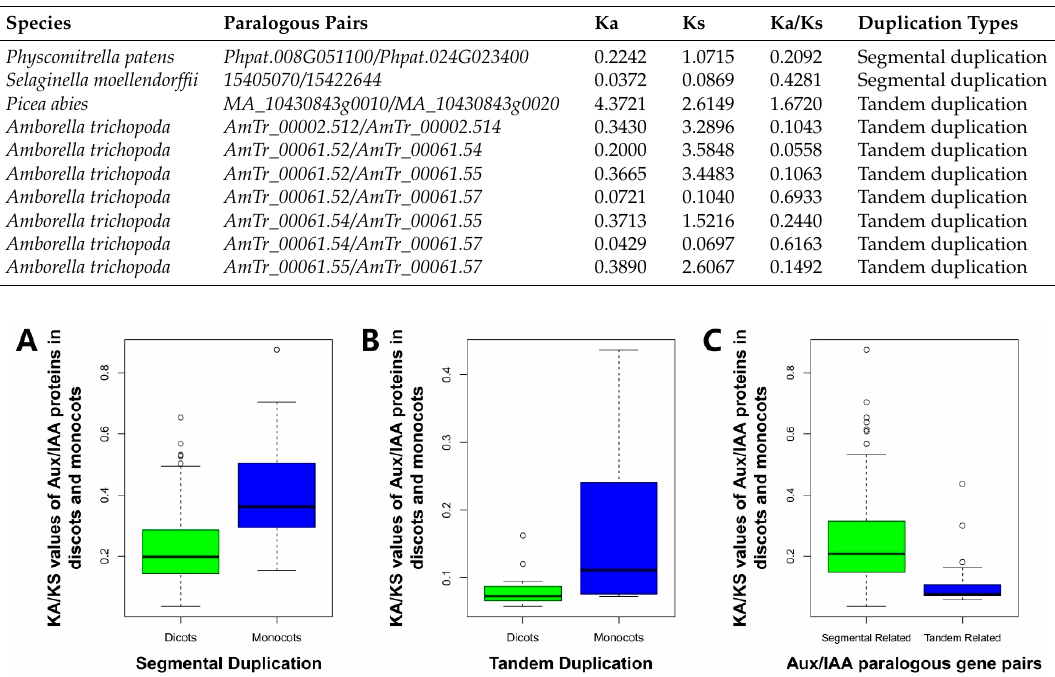
Table 2. Molecular evolutionary rate of selective duplicated Aux/IAA gene pairs in P. patens , S. moellendorffii , P. abies , and A. trichopoda .